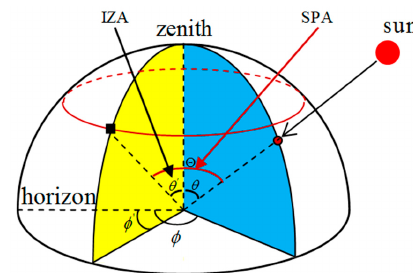
Figure 3. Relationship of the scattering angle, zenith angle and azimuthal angle in spherical coordinates (from ref. [44]).